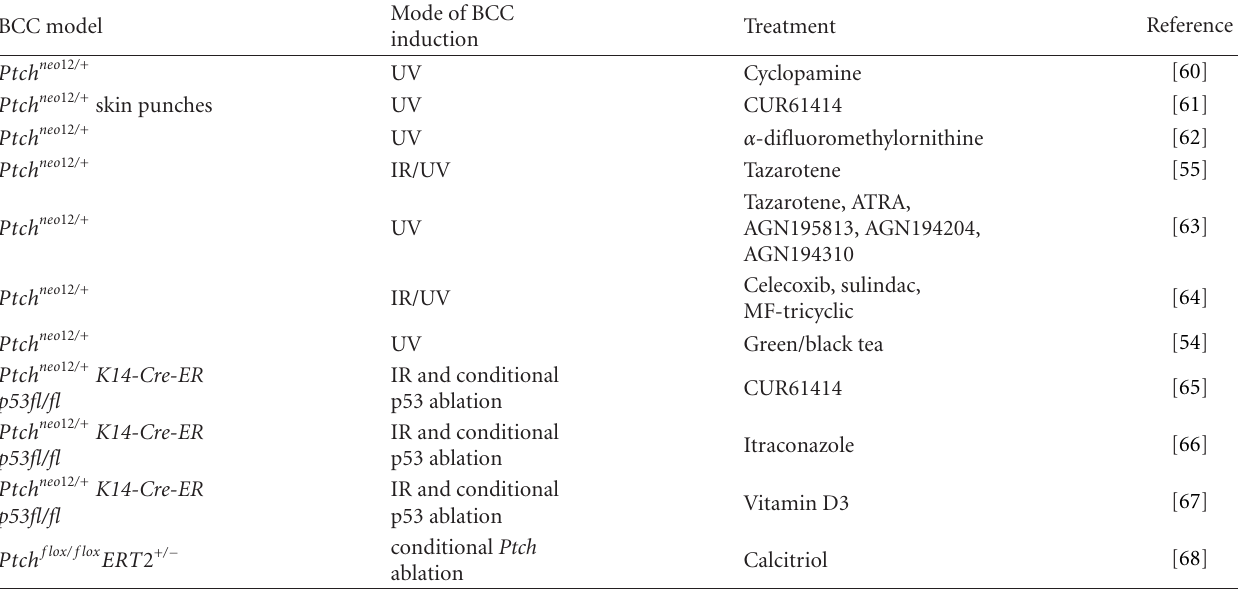
Table 1: Ptch knockout mouse models for preclinical BCC treatment